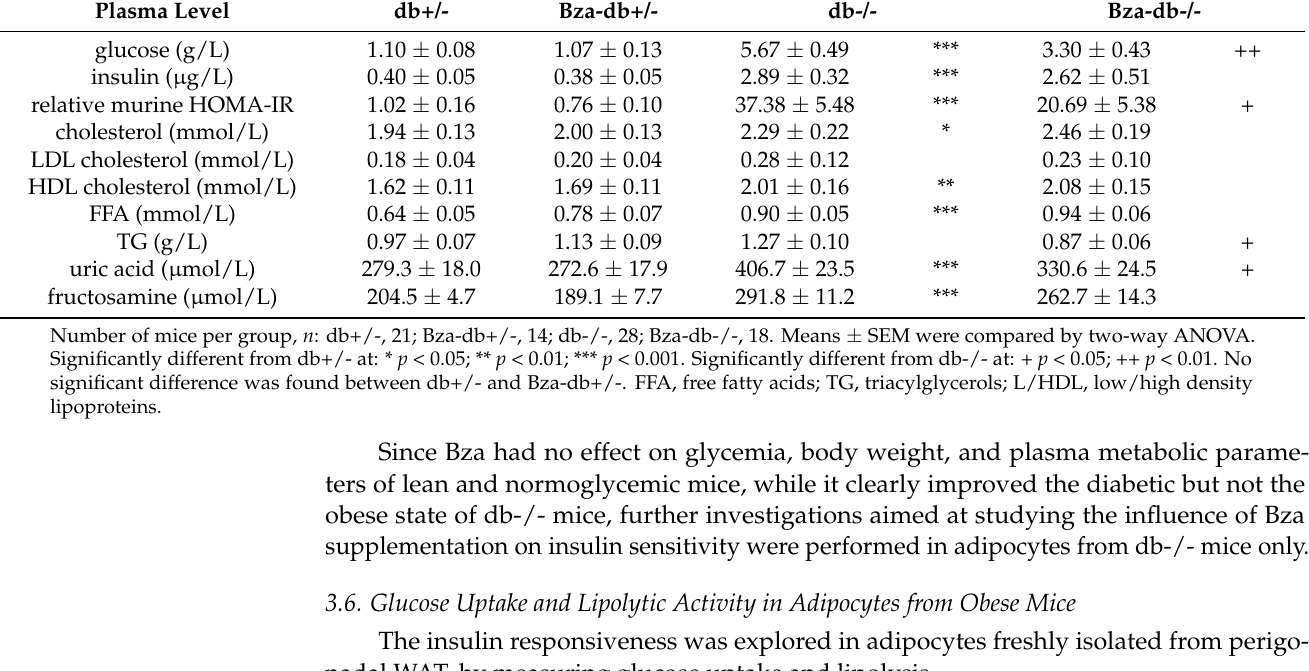
Table 3. Effect of benzylamine supplementation on plasma metabolic parameters in db+/- and db-/- after overnight fasting. Plasma